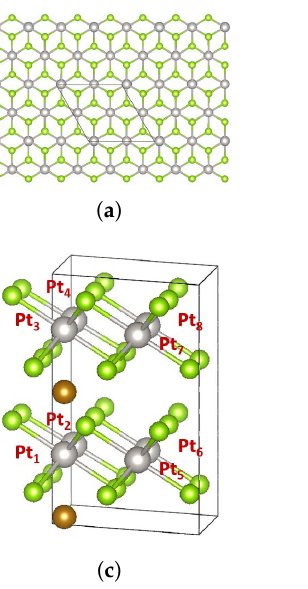
Figure 2. ( a ) Top view of the intercalated PtSe 2 . The original unit cell has 8 Pt atoms, 16 Se atoms, and 2 intercalant atoms. ( b ) The side view of the intercalated PtSe 2 . The in-plane ( J (cid:107) ) and out-of-plane ( J ⊥ ) exchange interactions are shown as well. ( c ) The PtSe 2 structure without vacancies. ( d ) The PtSe 2 structure with a Pt vacancy at the location of Pt 1